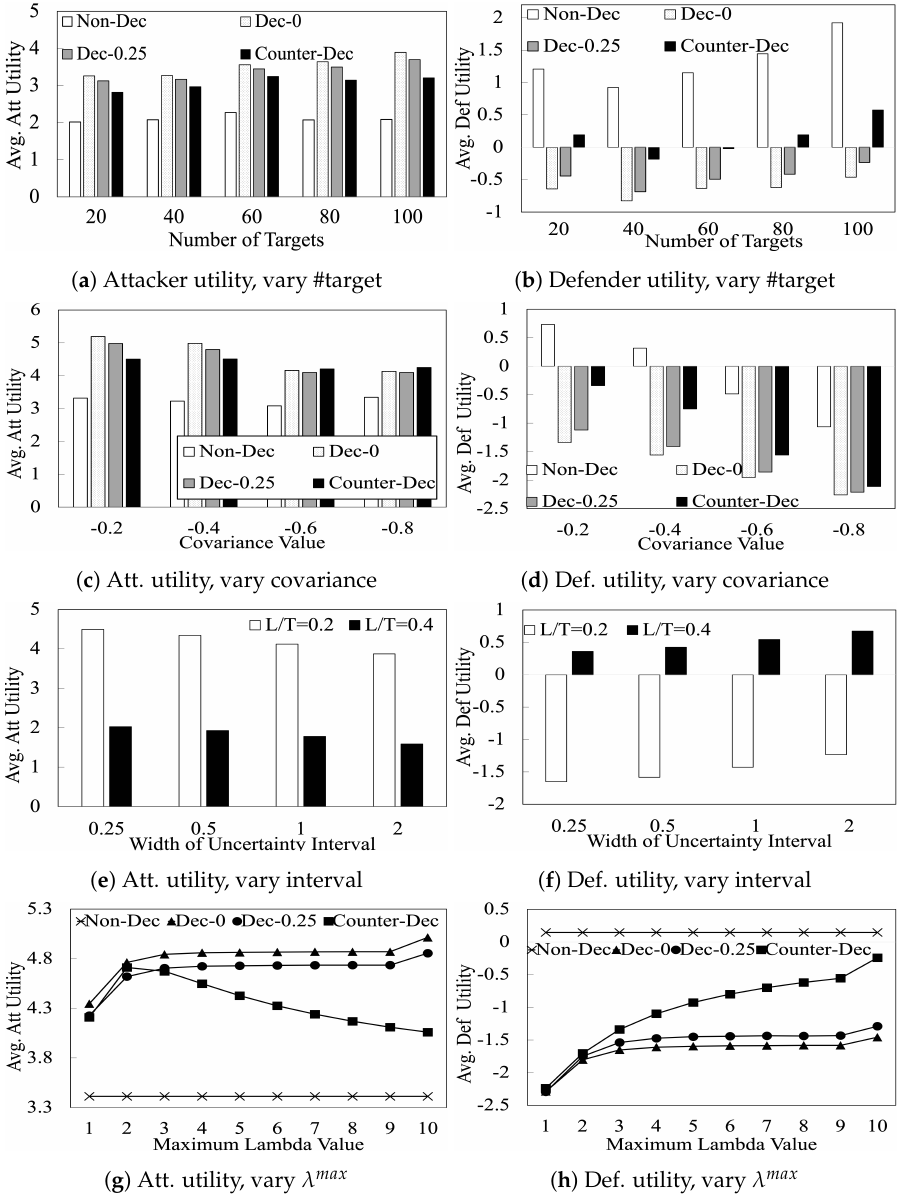
Figure 3. Evaluations on player